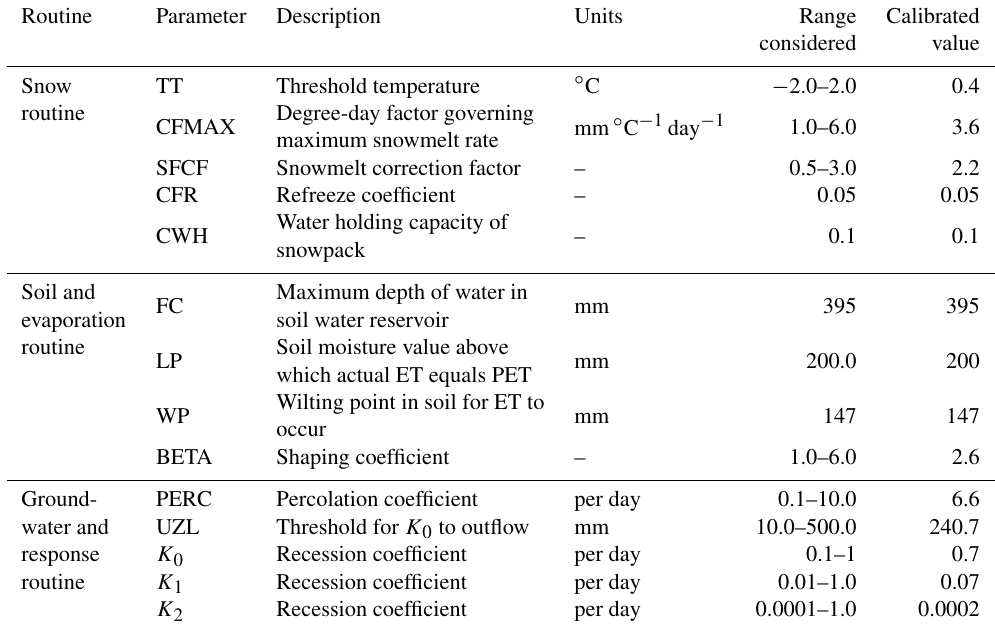
Table 3. Parameters used, the range considered for calibration, and the calibrated values.